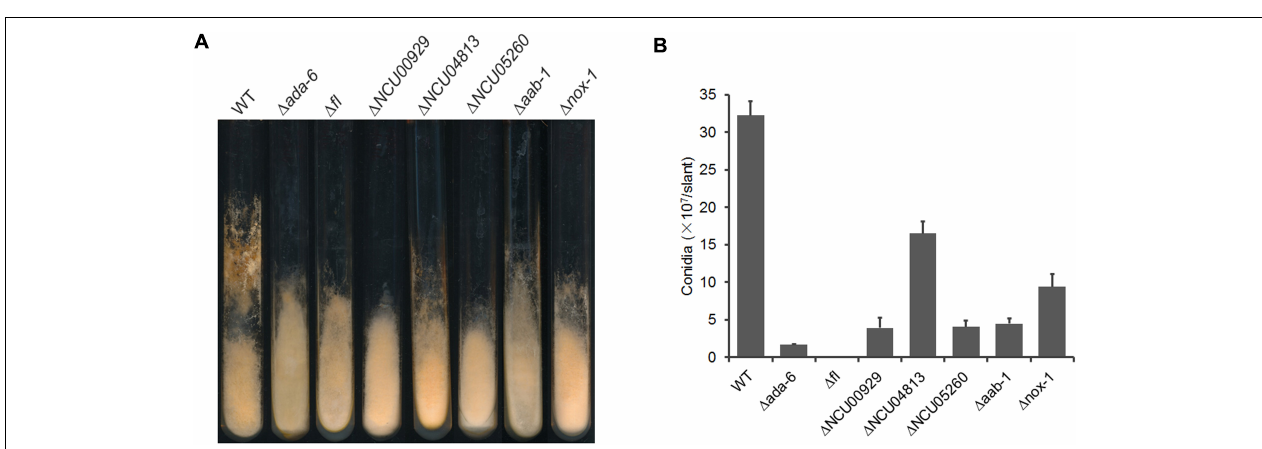
FIGURE 3 | Conidial production of the knockout mutants of genes regulated by ADA-6. (A) Wild type and knockout mutants were inoculated and grown on Vogel’s slants at 28 ◦ C with constant darkness for 1 day, and then transferred to constant light for another 6 days. Conidial production of each strain was documented as images. (B) Conidial production was measured as number of conidia per slant. Standard deviations from three replicates were marked by error